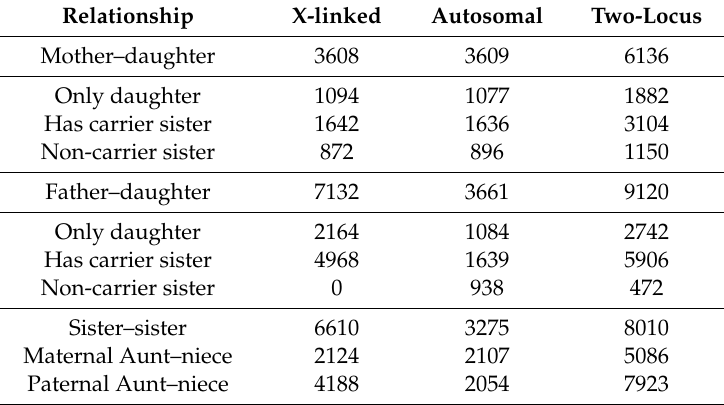
Table 2. Familial relationships among third-generation females who carry risk alleles (10,000 simulated families, λ = 2.4).